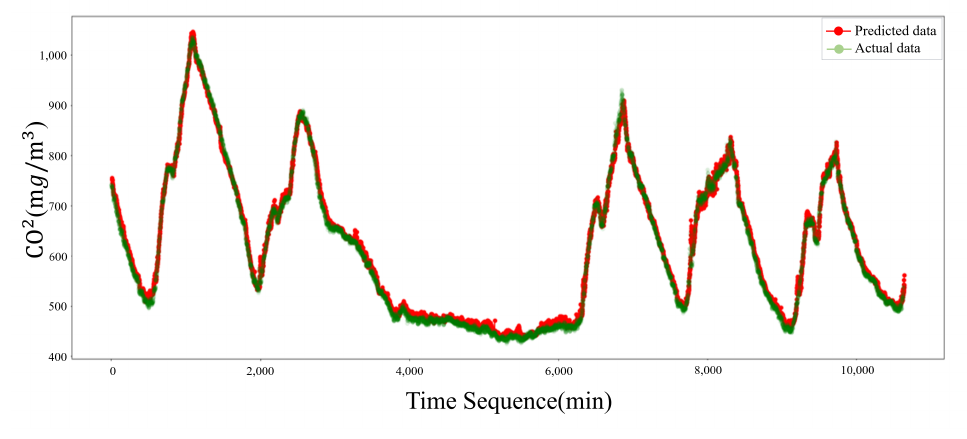
Figure 8. CO 2 Prediction Model. Table 4. Environment prediction model benchmark based on LSTM and GRU.